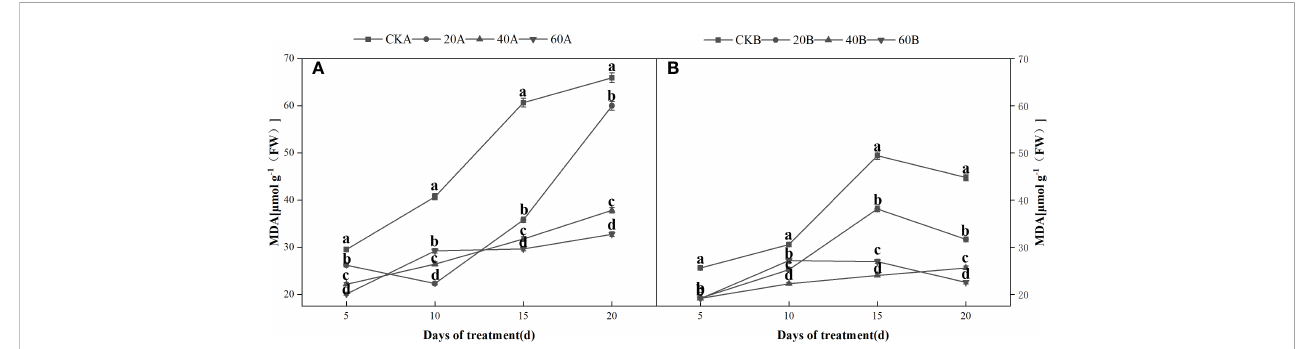
FIGURE 6 Effects of GA 3 on MDA content of light-sensitive maize inbred lines at different periods under low light stress. In the fi gure panels, 20A, 40A, and 60A denote SN98A sprayed with 20 mg L – 1 , 40 mg L – 1 , and 60 mg L – 1 GA 3 , respectively, and 20B, 40B, and 60B denote SN98B sprayed with 20 mg L – 1 , 40 mg L – 1 , and 60 mg L – 1 GA 3 . CKA denotes the SN98A control group sprayed with water and CKB denotes the SN98B control group sprayed with water. In the fi gure, (A) is the change of MDA in SN98A after GA 3 treatment, and (B) is the change of MDA in SN98B after GA 3 treatment. Values are expressed as mean ± SD of three replicates. Lower-case letters indicate the mean difference of different treatments in the same period, which is statistically signi fi cant